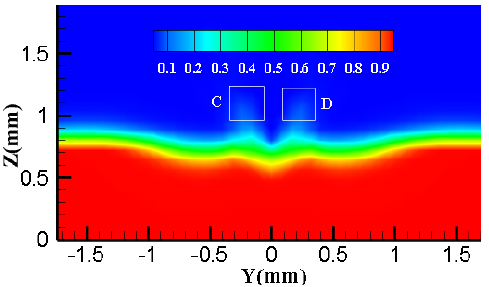
Figure 6. Cross section views of the calculated concentration profile of Ti at time t = 50.15 ms (laser power 500 W, and welding velocity 3.6 m/min).